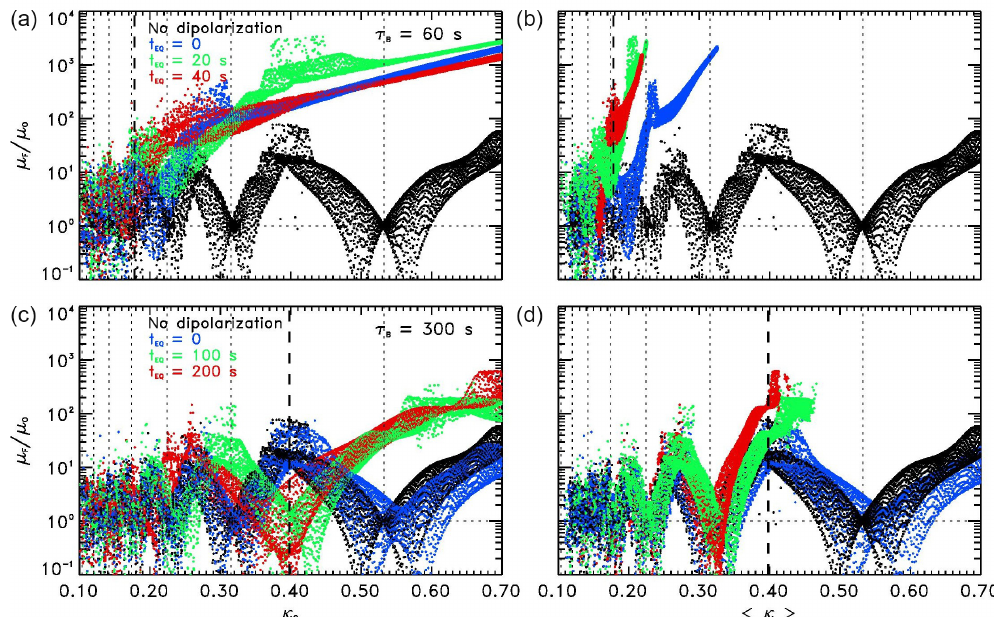
Figure 7. Final H + magnetic moment as a function of parameter κ for different (color-coded) equatorial crossing times. A 60 (top) or 300s (bottom) magnetic transition is considered. In the left and right panels, the initial κ value and the average κ value at equatorial crossing are considered, respectively. The dashed vertical line shows the κ value corresponding to the peak E x B drift speed (denoted by κ E x B in the text). Vertical dotted lines show the expected energy resonances (Eq. 2).